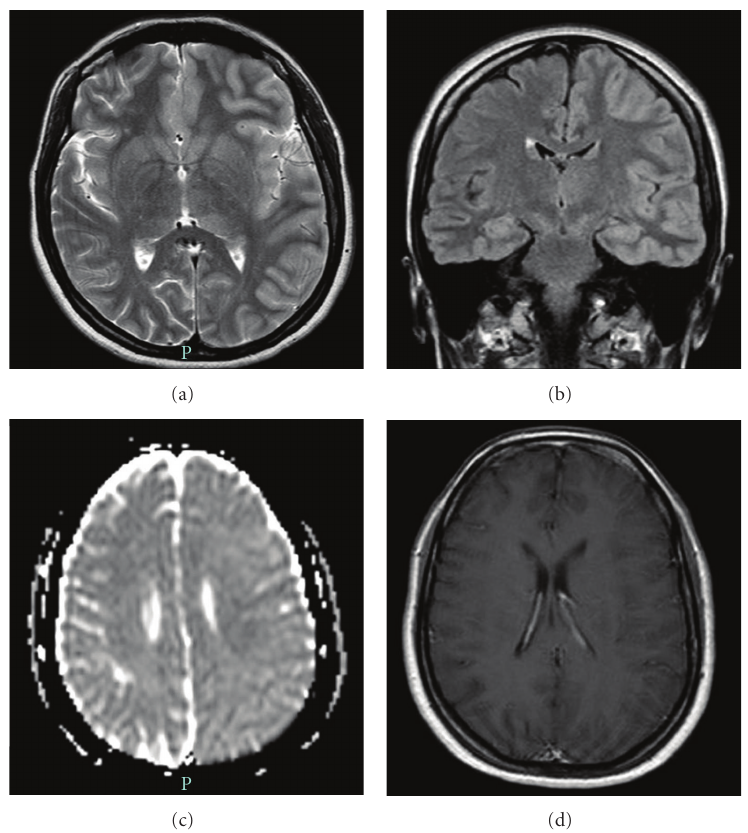
Figure 2: MRI of the patient at the time of presentation. (a) Transverse fast spin-echo T2-weighted MR images through the level of the sylvian fissures show di ff use cortical swelling and mild cortical hyperintensity of the left cerebral hemisphere. These findings are most likely caused by cortical edema. (b) Coronal di ff usion-weighted MR image through the level of the basal ganglia shows di ff use high signal of the cortex of the left cerebral hemisphere. (c) Di ff usion-weighted images show no evidence of water restriction in the left hemisphere. (d) Postcontrast study shows that the area does not enhance on T1-weighted images after contrast